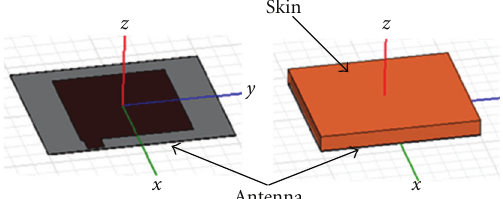
Figure 3: Images of antenna and antenna-skin simulation